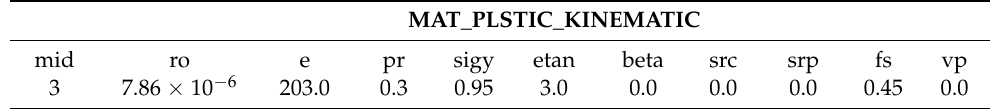
Table 2. Material card for fiber reinforcement (kg, mm, ms, kN, GPa).